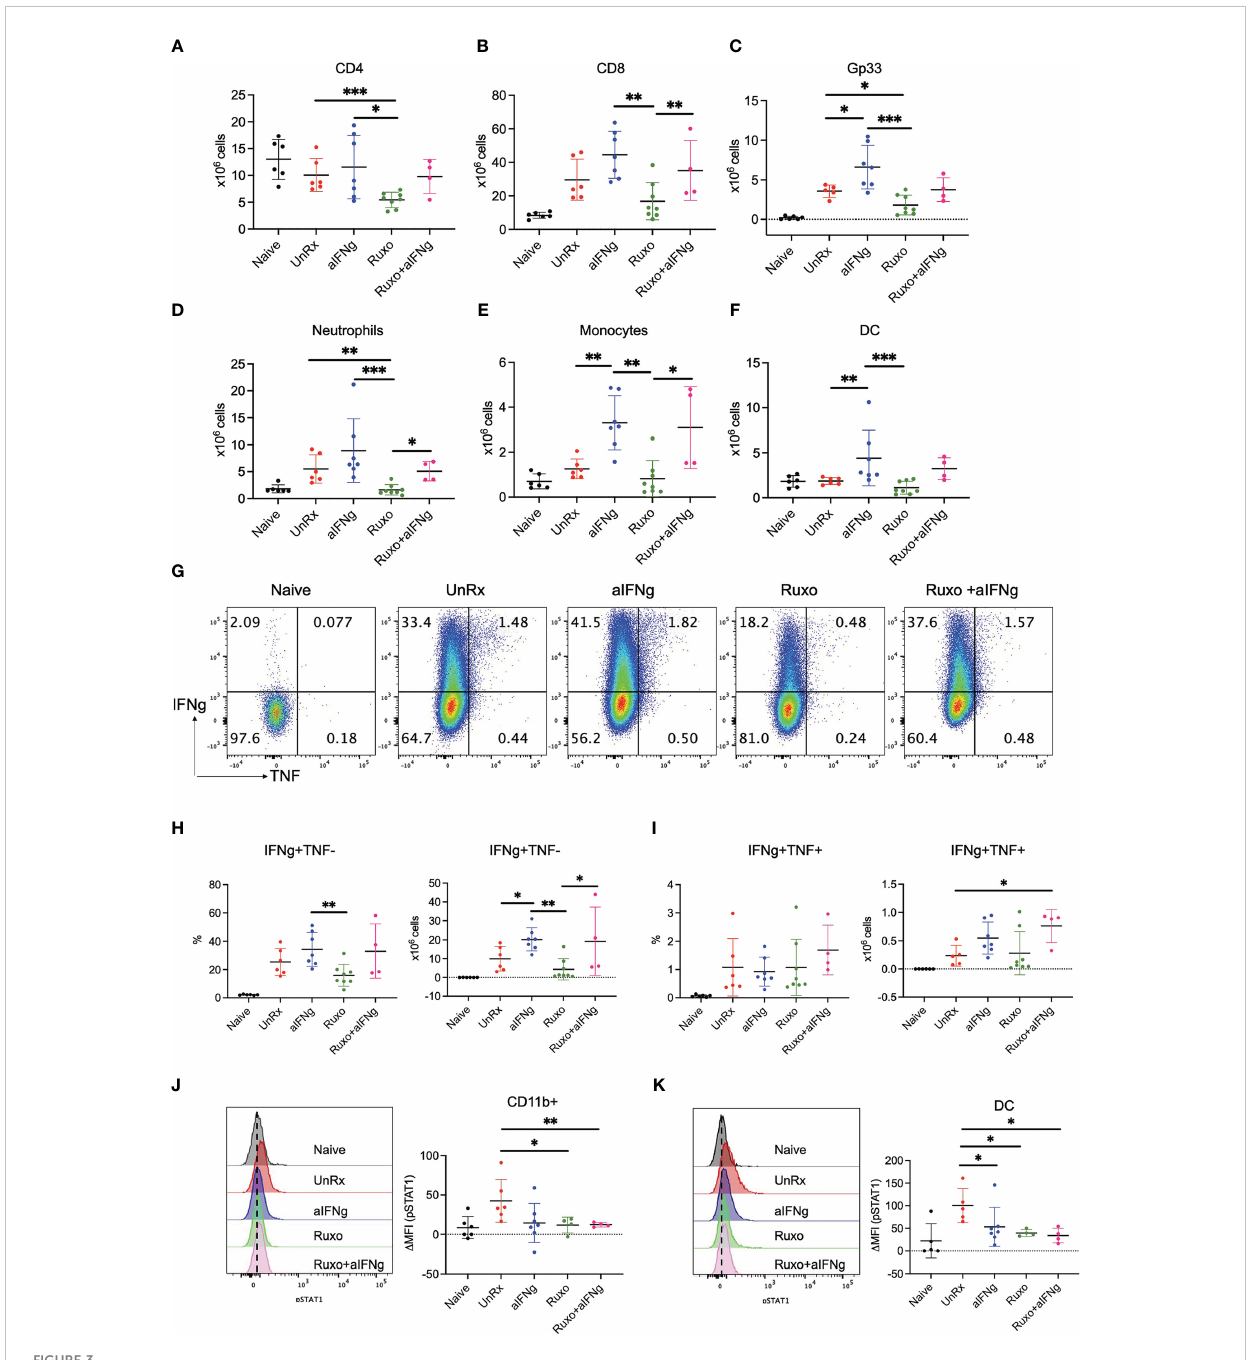
FIGURE 3 Impact of aIFNg, ruxolitinib, or combination treatment on immune cell numbers and function in Prf1 − / − mice infected with LCMV Armstrong. On day 9 p.i., splenocytes from naïve mice, or LCMV-infected mice that were UnRx or treated with aIFNg, ruxolitinib, or combination treatment were analyzed by fl ow cytometry. Absolute numbers of splenic CD4 T cells (A) , CD8 T cells (B) , Gp33 tetramer-positive CD8 T cells (C) , neutrophils (D) , monocytes (E) , and dendritic cells (DCs; F ). Representative dot plots (G) and summary graphs (H, I) showing the frequencies and absolute numbers of IFNg and/or TNF-producing effector CD8 T cells following ex vivo restimulation with gp33 peptide. Cells were gated on CD44+CD62L  effector CD8 T cells. Representative histograms (left) and summarized data (right) of the delta mean fl uorescence intensity (MFI) of STAT1 phosphorylation in CD11b  myeloid cells in relation to MFI in naïve mice (J) and DCs (K) . Data points were combined from two independent experiments and each data point represents one mouse. * P < 0.05, ** P <